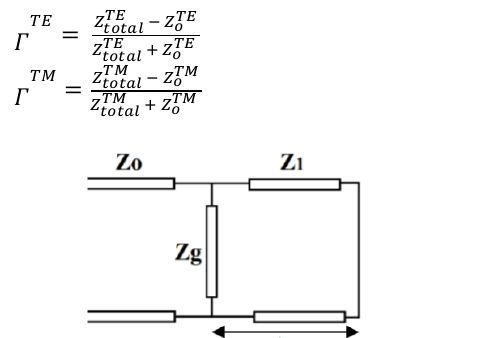
Figure 3: Equivalent transmission line network for a grounded dielectric slab loaded by a surface impedance.